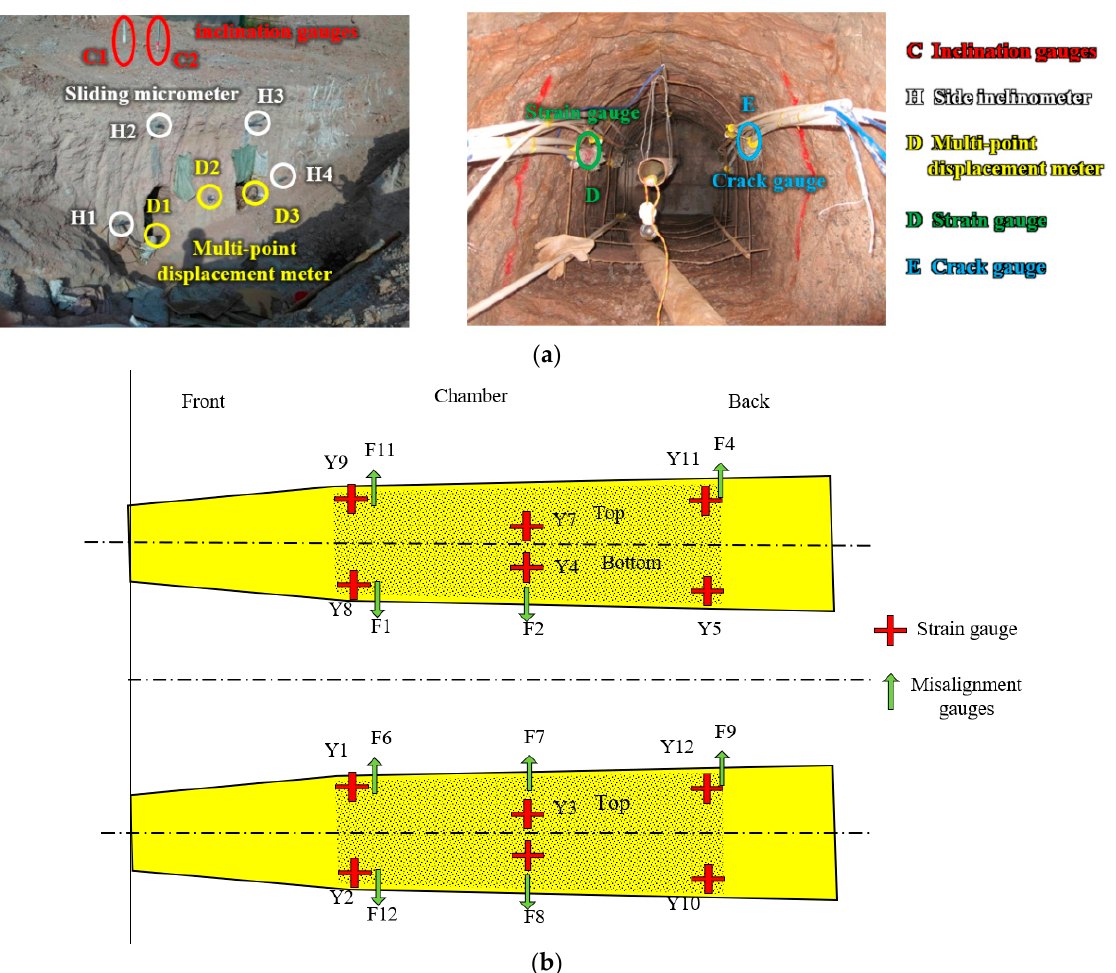
Figure 2. Schematic diagram of the anchor body measurement point arrangement: ( a ) anchor plug body enclosure deformation measurement; ( b ) anchor body strain gauge and dislocation gauge.